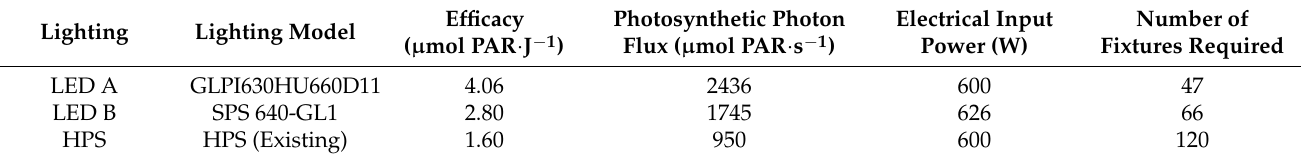
Table 5. Properties of HPS and LED lights used in